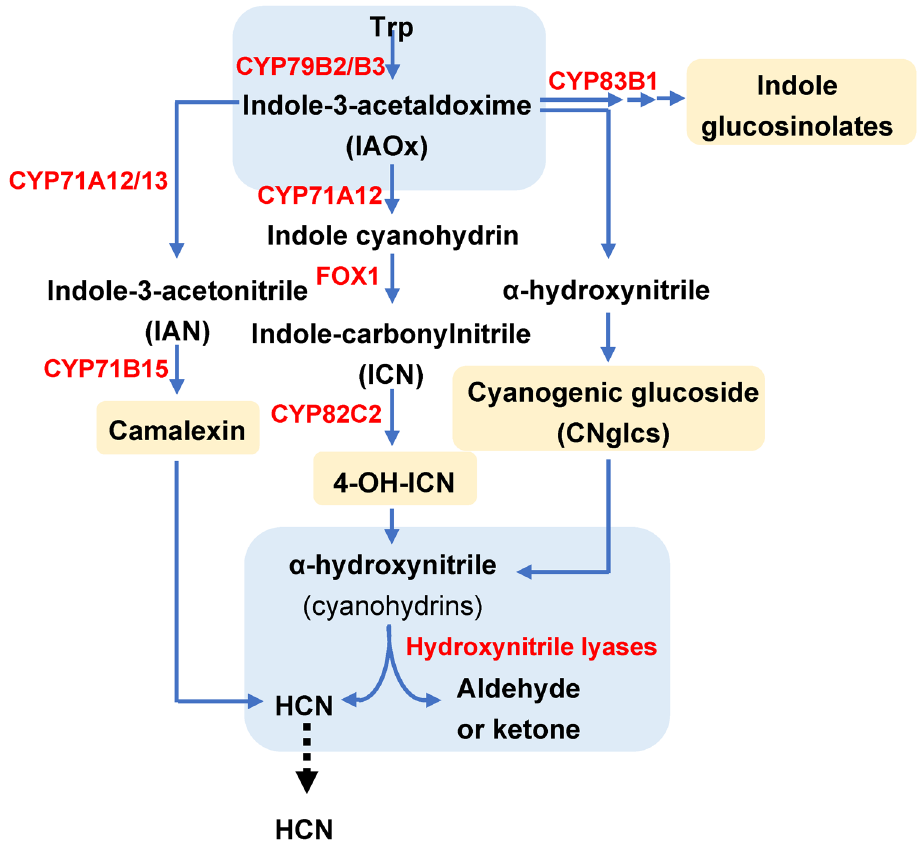
Figure 3. Scheme of different plant pathways involved in HCN production, dependent on the plant species. Enzymes are indicated in red. Yellow boxes indicate final products of each pathway, and blue boxes indicate common convergence points in the network of pathways. Adapted from Araniz et al. [ 20] .